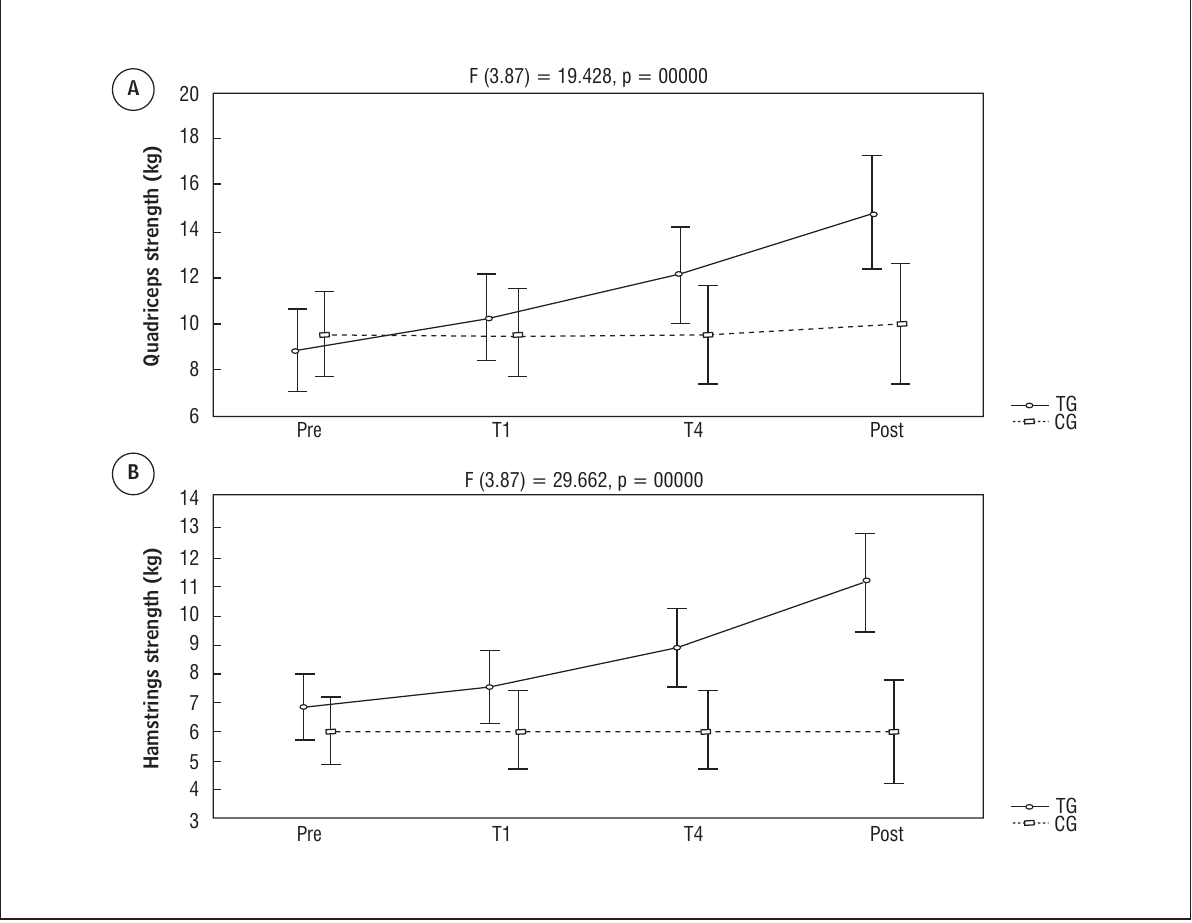
Figure 2 – Mean and confidence interval for the strength of the quadriceps (A) and hamstrings (B) Note: TG = Training Group (solid line); CG = Control Group (dotted line); Pre = pre-training period; T1 = after the familiarization week; T4 = four weeks after the start of intervention; Post = post-training